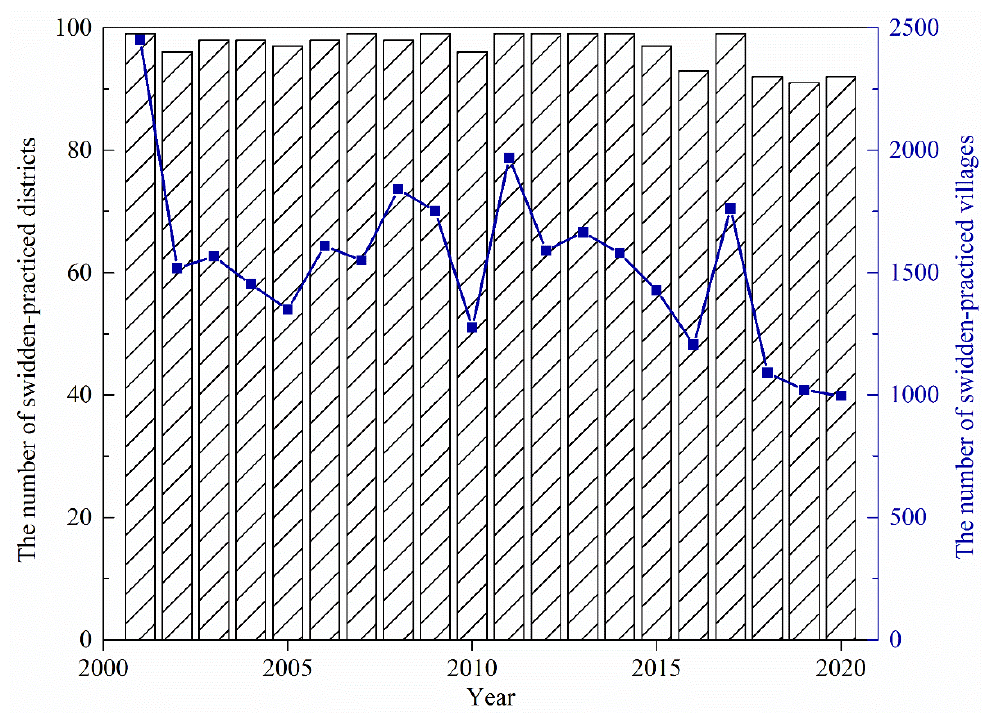
Figure 7. Statistics of annual number of villages and districts with swidden agriculture landscape (SAL) in northern Laos during 2001 – 2020.